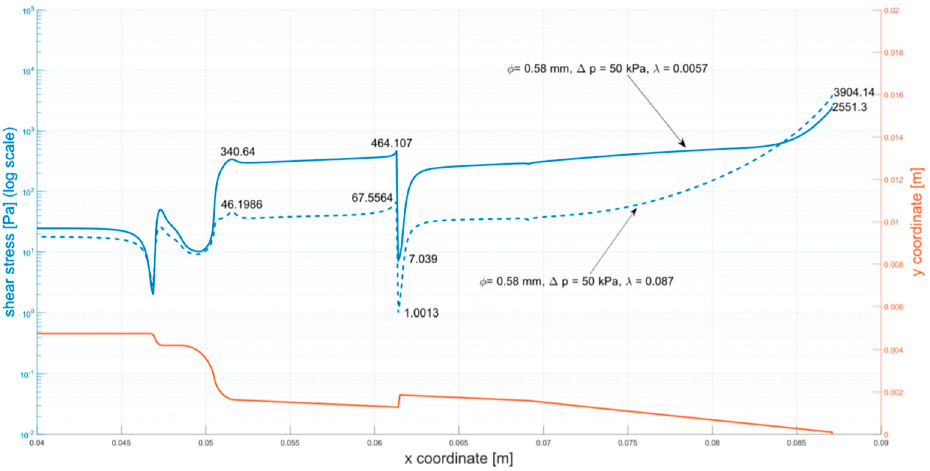
Figure A4. Shear stress at the walls of the cartridge ( φ = 0.58 mm, ∆ p = 50 kPa).